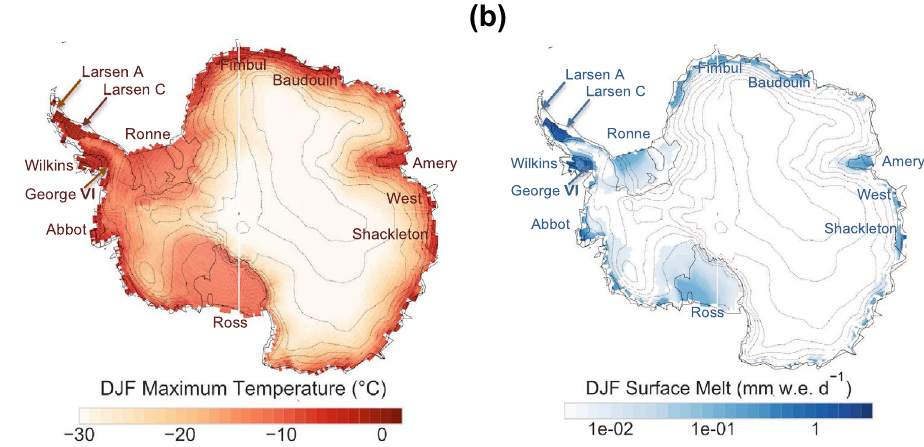
Figure 1 . Summer temperatures along coastlines are frequently above 0 °C. ( a ) Mean daily DJF maximum air temperatures (TX). ( b ) Mean daily DJF surface melt (SM) intensities. Data over the period 1981–2010 were used (from the ERA5 dataset in case of the temperature and from the RACMO2 model in case of the surface melt). Plots were generated by using Python’s Matplotlib Library 44